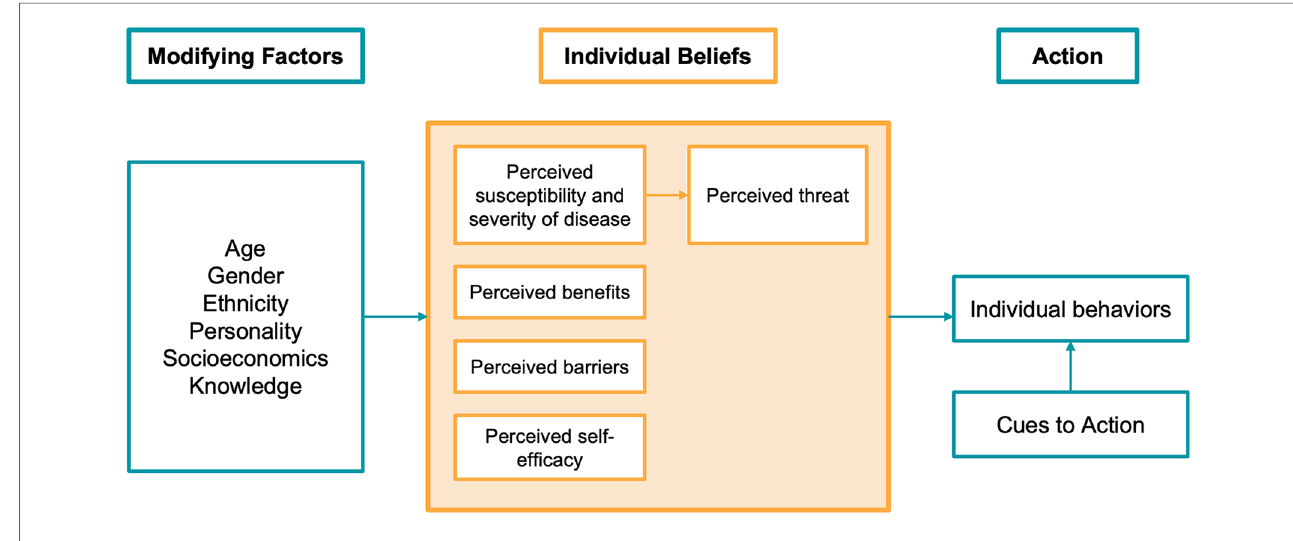
FIGURE 1 Health belief model components and linkages